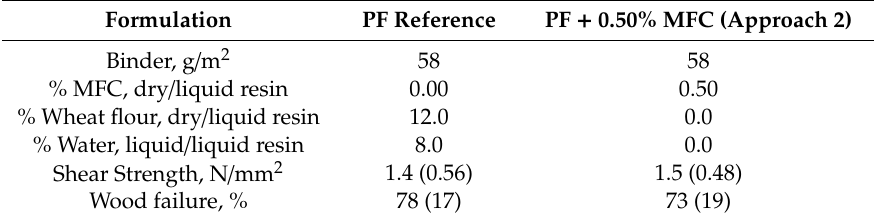
Table 12. Plywood panels analysis, MFC 10%, Approach 2.